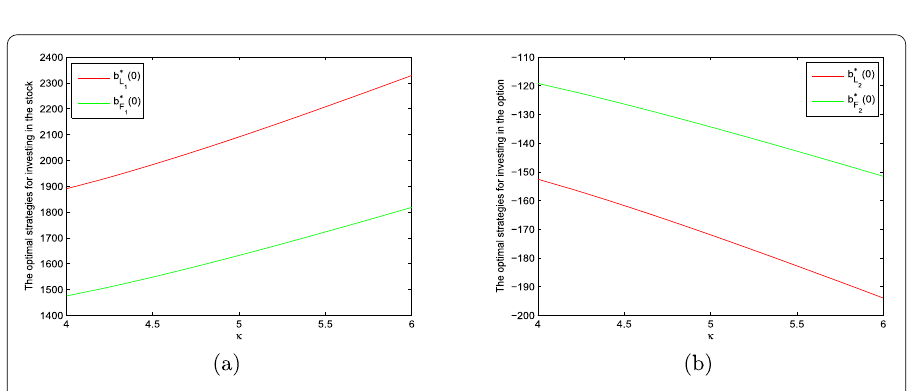
Figure 4 Sensitivities of optimal investment strategies to parameter κ